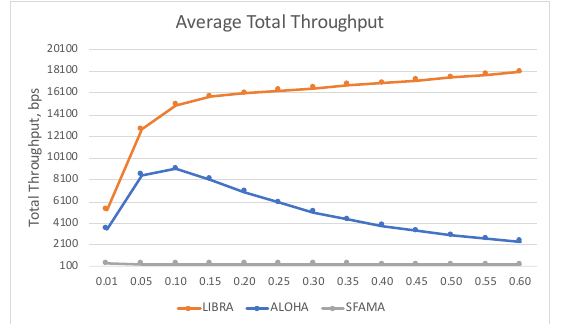
Figure 9. Total network throughput in traffic scenario, in bps.